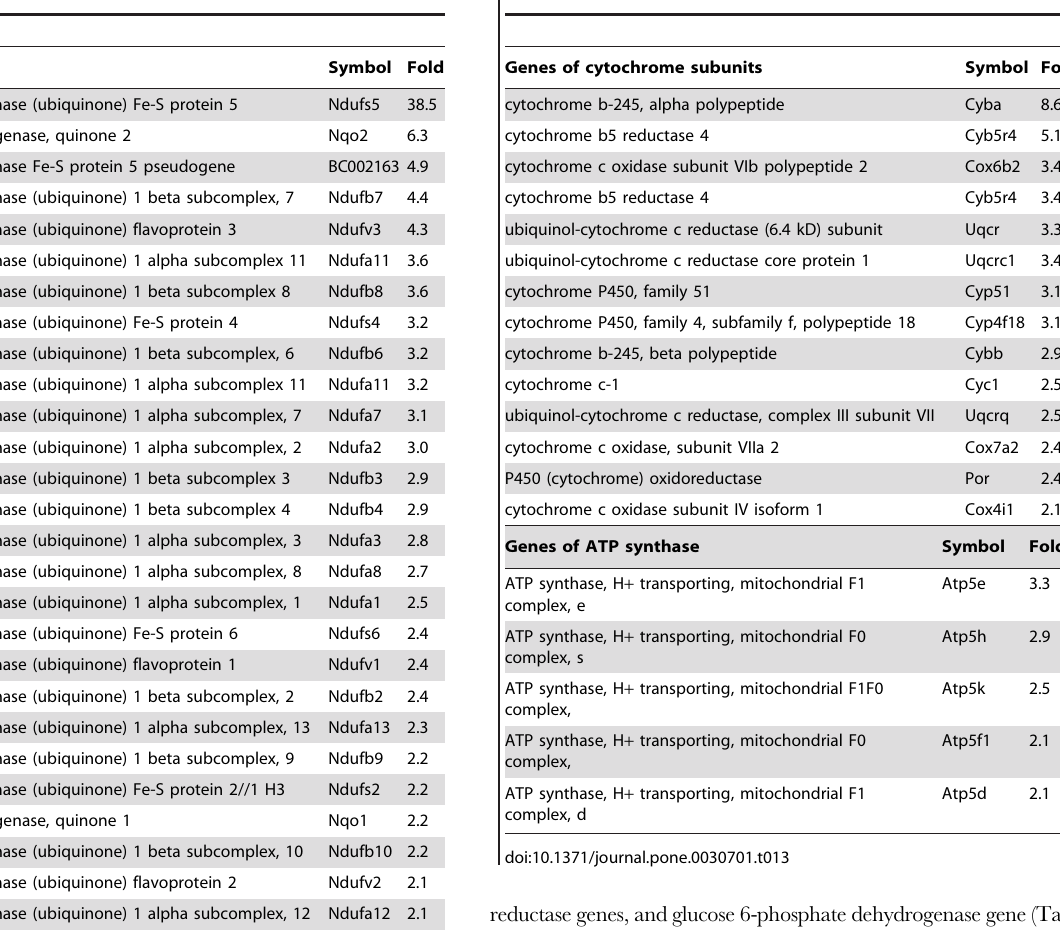
Table 12. Up and down-regulation of mitochondrial NADH dehydrogenases in lal 2 / 2 bone marrow MDSCs.